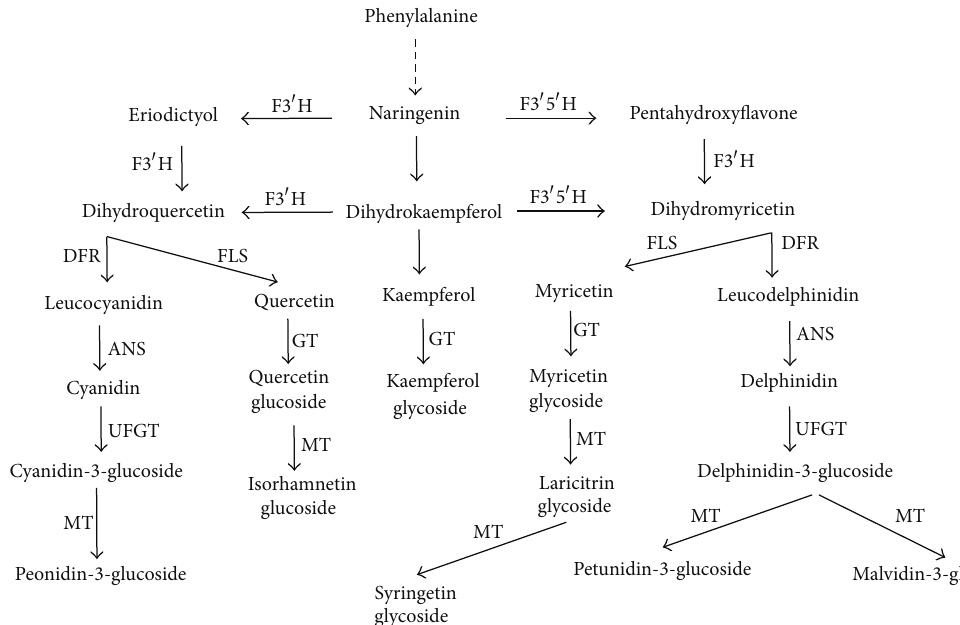
Figure 1: Flavonoid biosynthetic pathway. PAL: phenyl ammonia lyase, F3 󸀠 H: flavonoid-3 󸀠 -hydroxylase, F3 󸀠 5 󸀠 H: flavonoid-3 󸀠 ,5 󸀠 -hydroxylase, UFGT: UDP-glucose: flavonoid 3-O-glucosyltransferase, MT: methyl transferase, DFR: dihydroxyflavanol-4-reductase, ANS: anthocyanin synthase, and FLS: flavonol